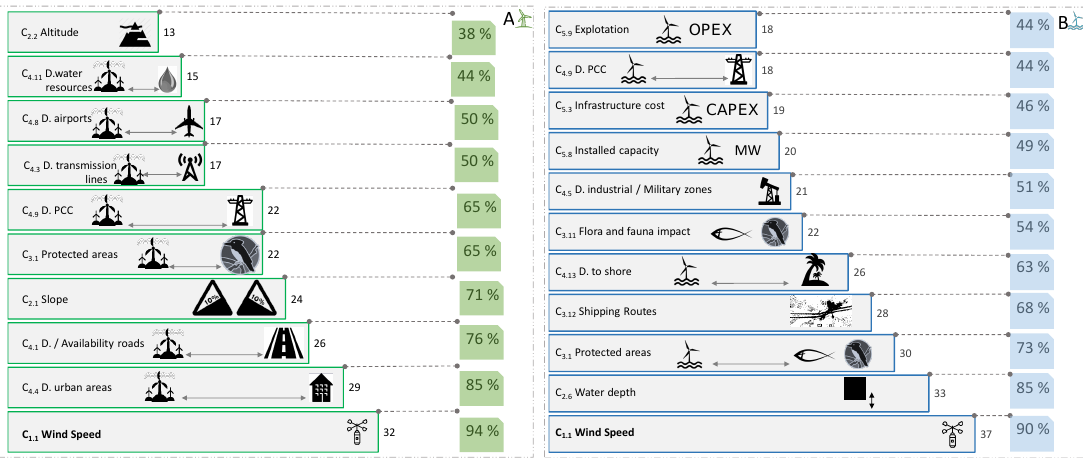
Figure 9. Relevant factors for optimal location methodologies. ( A ) Onshore wind power plant. ( B ) Offshore wind power